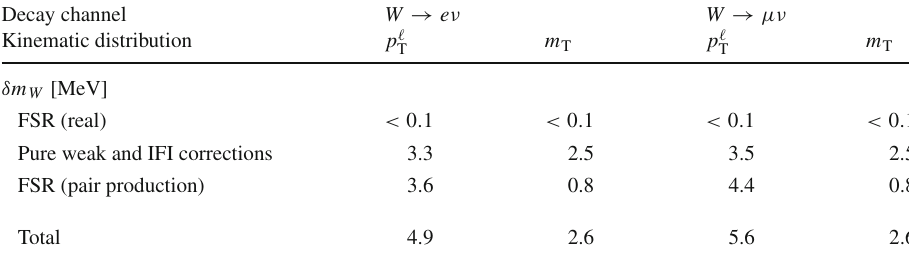
Decay channel W → e